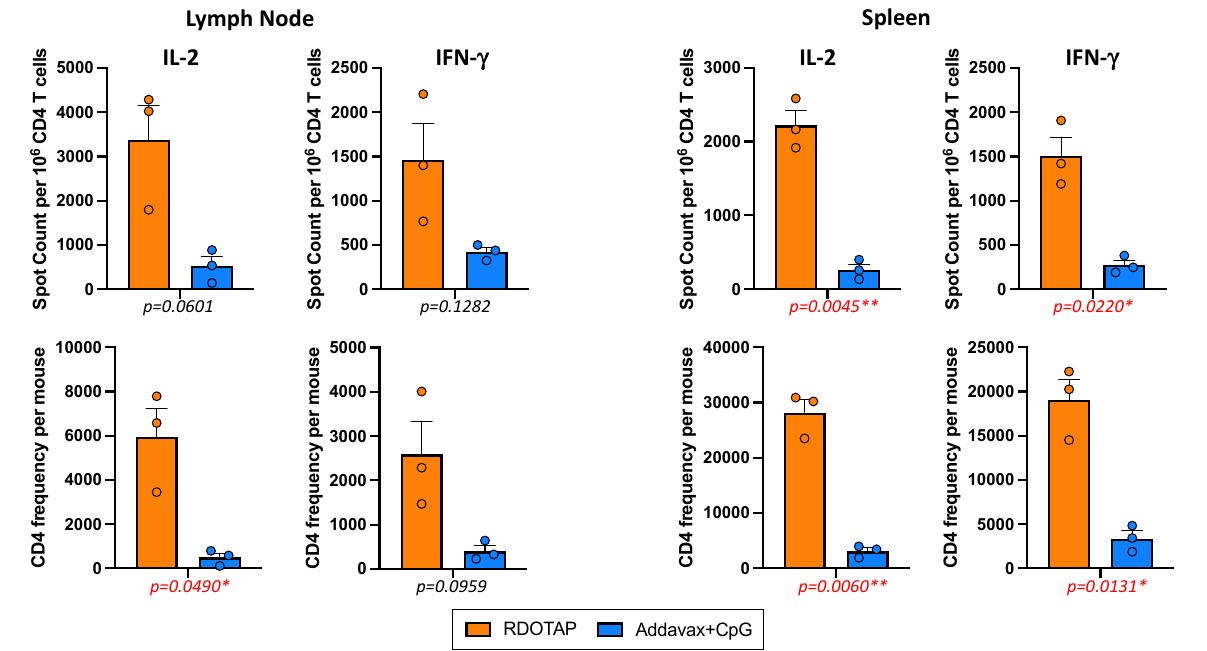
Figure 3. Mice were immunized subcutaneously with B/Malaysia HA protein emulsified in the indicated adjuvant (R-DOTAP, orange or AddaVax + CpG, blue), and tissues were harvested at day 10/11 post vaccination. Tissues from 3–4 mice were pooled in each experiment. The HA-B reactive CD4 T cells in the draining popliteal lymph node ( left ) and the number of HA-B reactive CD4 T cells in the spleen ( right ) detected by IL-2 and IFN- γ ELISpot. The top graphs show the frequency of HA-B epitope specific cytokine-producing CD4 cells per million and the bottom graphs illustrate the HAB epitope-specific cytokine-producing cells per mouse. All data have been corrected for background. Shown as a bar is the average of three independent experiments with each experiment shown as a circle and the standard error of the mean indicated. Below the plot is the p -value calculated using an unpaired t -test with Welch’s correction (* p ≤ 0.05 and ** p ≤ 0.01). Table 2. CD4 T cell yields following purification from subcutaneous vaccination with HA B/Malaysia protein emulsified in R-DOTAP or AddaVax + CpG. Adjuvant Exp1 Exp2 Exp3